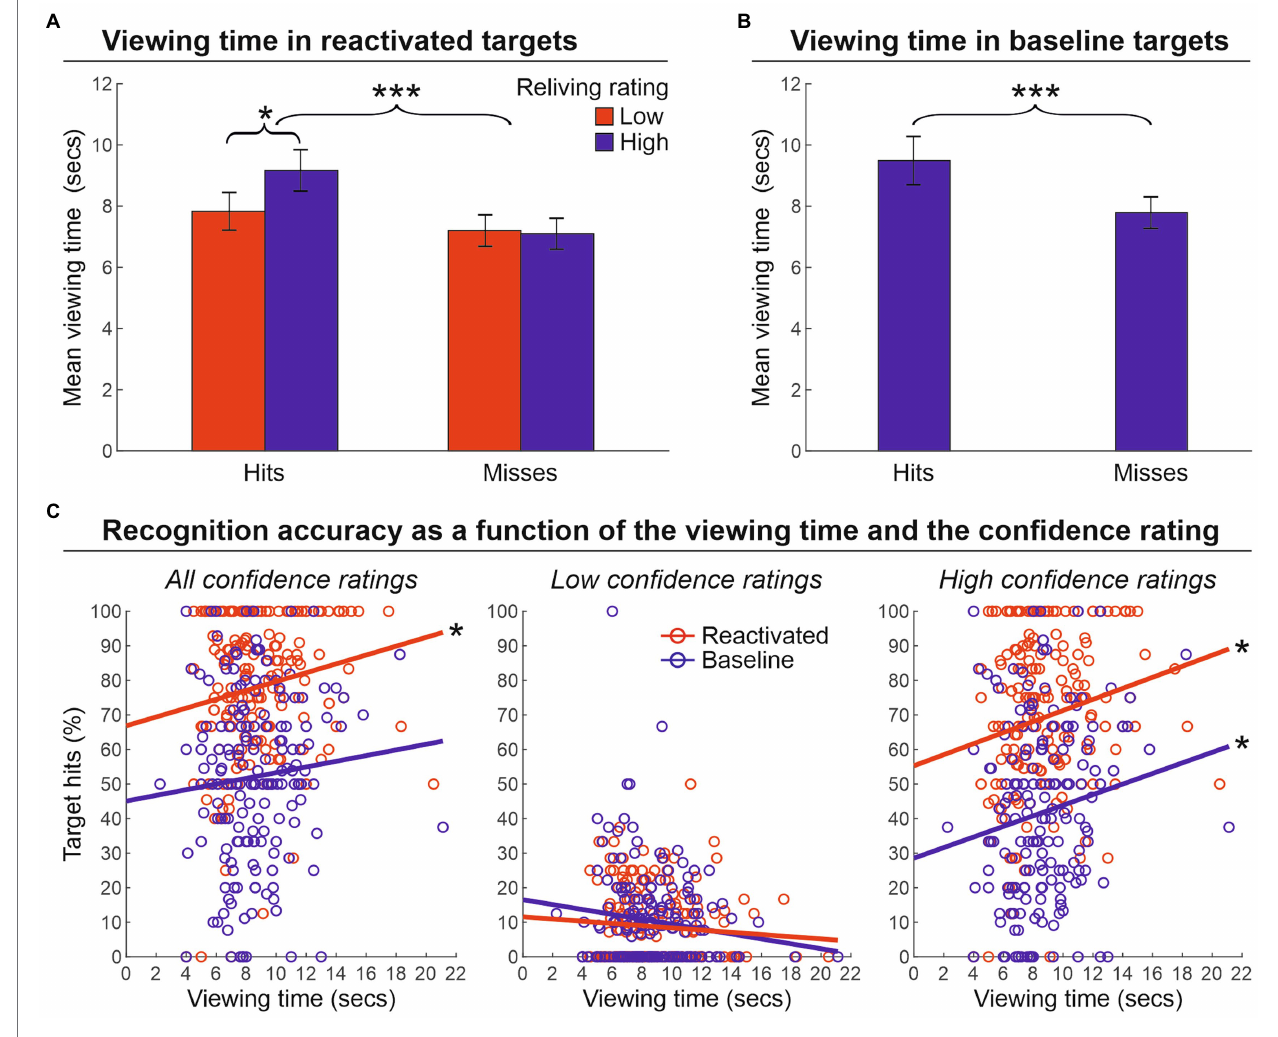
FIGURE 3 | Viewing time. (A) Mean viewing time (± the standard error of the mean) in reactivated targets that were recognized (hits) or not (misses) at the memory recognition task (phase 3) according to the reliving rating reported during the reactivation procedure (phase 2). This shows greater viewing time for hits vs. misses, and also greater viewing time for high reliving rate hit targets. (B) Mean viewing time (± the standard error of the mean) in baseline targets, indicating a greater viewing time spent for non-reactivated targets subsequently recognized (hit) vs. missed in the recognition memory task (phase 3). (C) The relationship between recognition accuracy and viewing time. The graphs show that when higher confidence scores are considered, the recognition accuracy of both reactivated and baseline targets benefited from a longer viewing time. *** p < 0.001; * p <